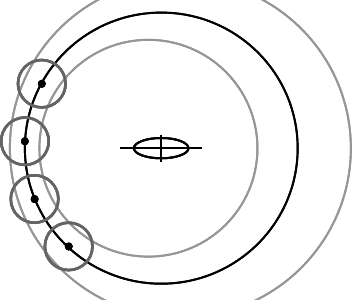
(Fig. 5). The minimum distance of the two notches is